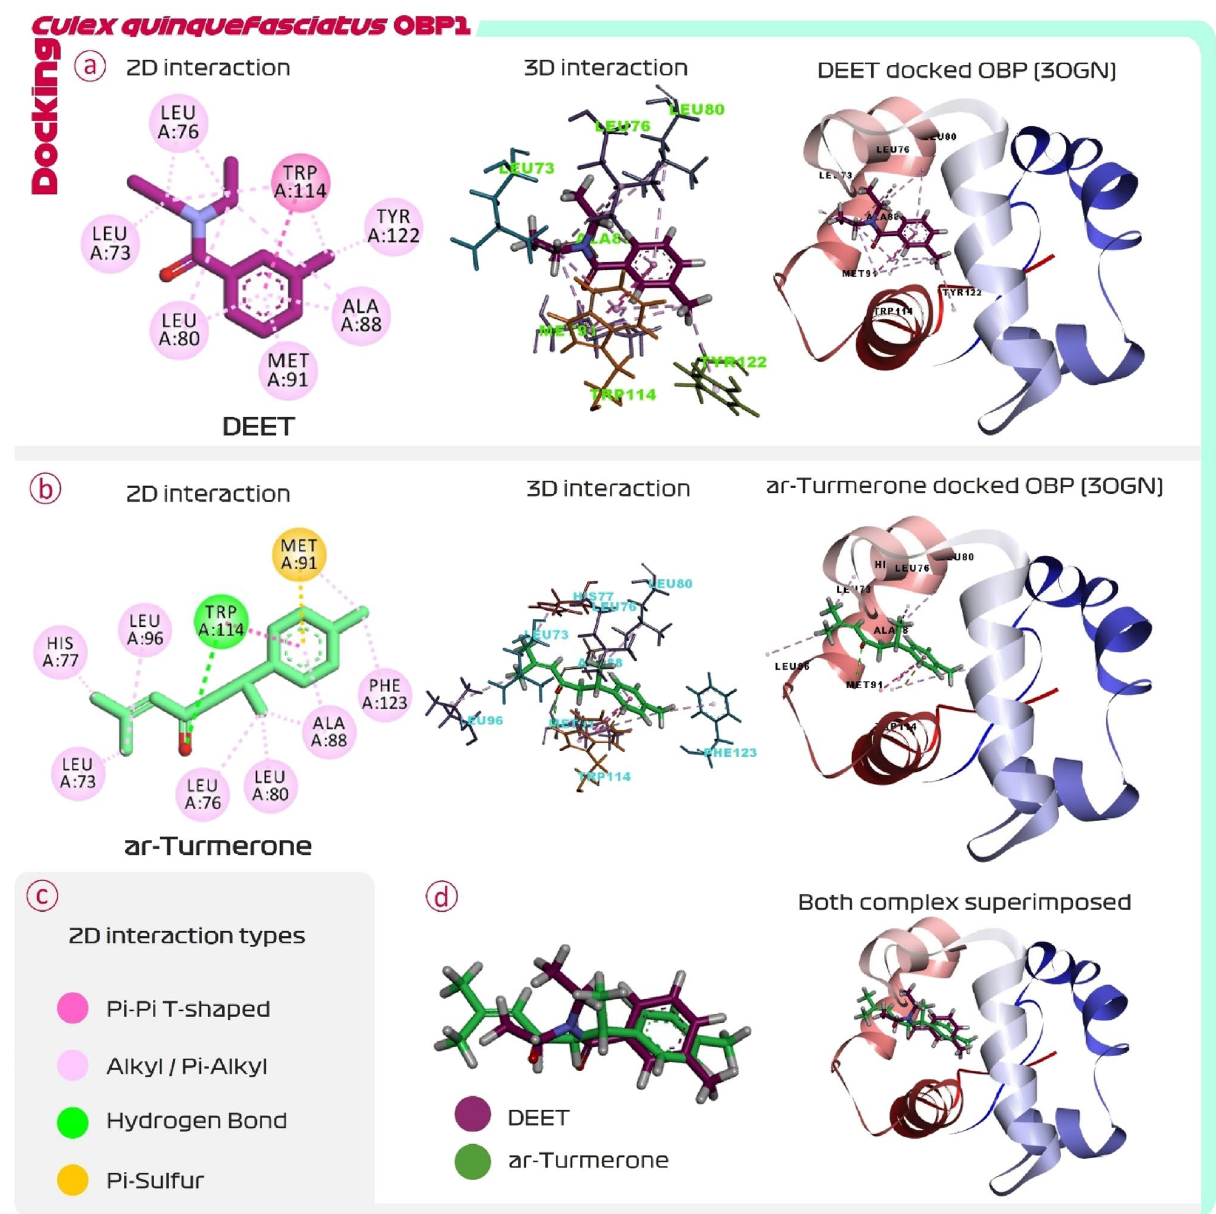
Figure 1. Molecular docking of ( a ) DEET and ( b ) ar-turmerone with OBP1 (3OGN) of C. quinquefasciatus, ( c ) interaction types and ( d ) superimposition of docked DEET and recruits Leu80, Ala88 and Met91 all by forming alkyl/pi-alkyl interactions. The methyl group of aromatic ring further interact with Tyr122. The methyl groups attached to nitrogen interacts with Leu73 and Leu76 by forming alkyl/pi-alkyl interactions. All the interactions formed by DEET with OBP1 tends to be hydrophobic in nature and there exists no formation of hydrogen (H) bonds between this ligand and protein (Fig. 1). The binding energy of this interaction is found to be − 6.81 kcal/mol (Table 1). Docking of phytochemicals of C. longa with OBP1 showed that top three compounds that based on binding energy from docking are dihydrocurcumin, bisdemethoxycurcumin, and ar-turmerone with the binding energies − 11.21, − 10.68, and − 9.043 kcal/mol respectively. Dihydrocurcumin, and Bisdemethoxycurcumin are non- volatile in nature hence its interaction with OBP1 is low, but ar-turmerone is volatile in nature and is reported to have strong mosquito repellent potentials. Therefore, ar-turmerone being volatile and showing strong ability to interact with OBP1 based on XP docking score of − 9.043 kcal/mol is a definite lucrative lead molecule from the lot of curcuminoids. The docking score obtained for all the curcuminoids under study is represented in Table 1. Interaction of ar-turmerone with OBP1 (3OGN) is represented in Fig. 1. Like DEET, ar-turmerone too, have aromatic ring that interacts with Trp114 by making pi-pi t-shaped interaction, the ketone group further interacts with Trp114 by making H-bond. This interaction further strengthens the interaction of Trp114 with the contact